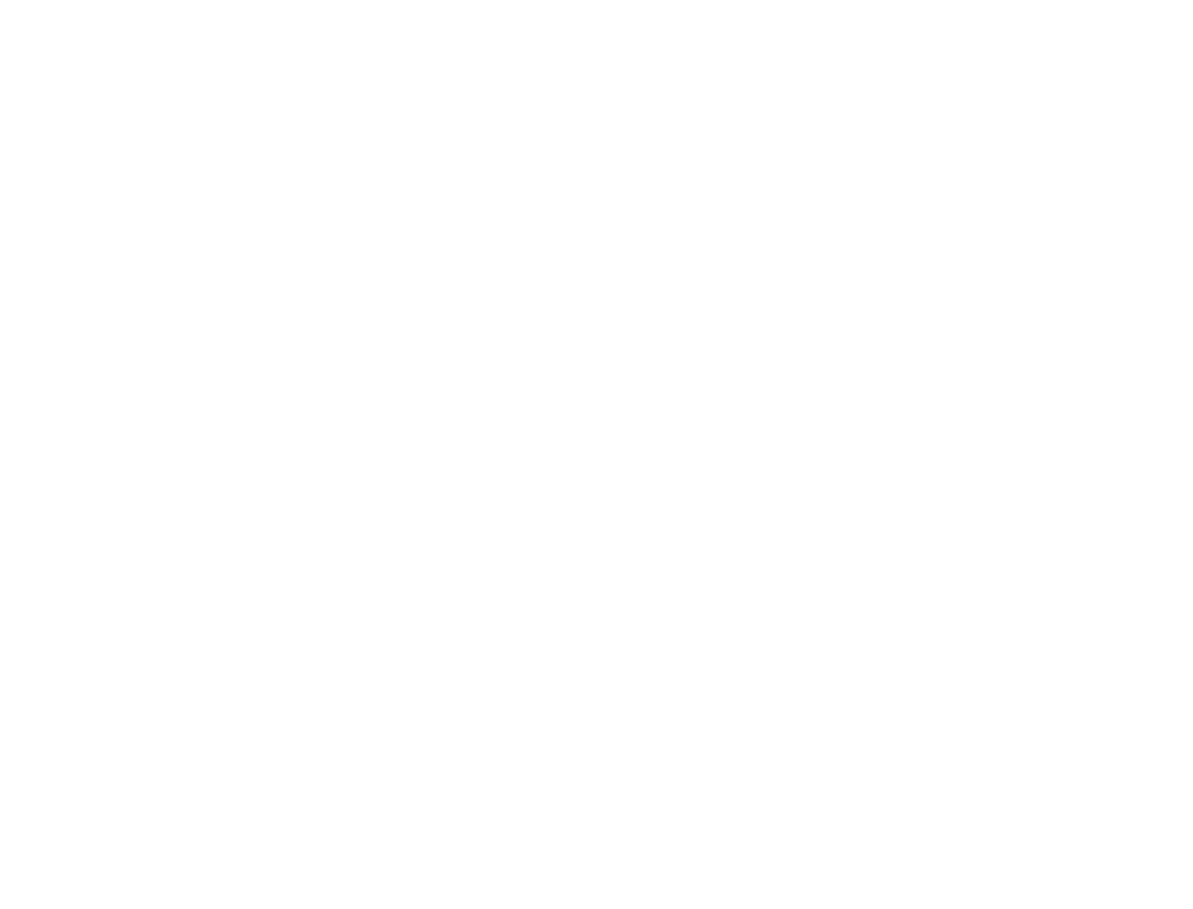
Frontiers in Bioengineering and Biotechnology |